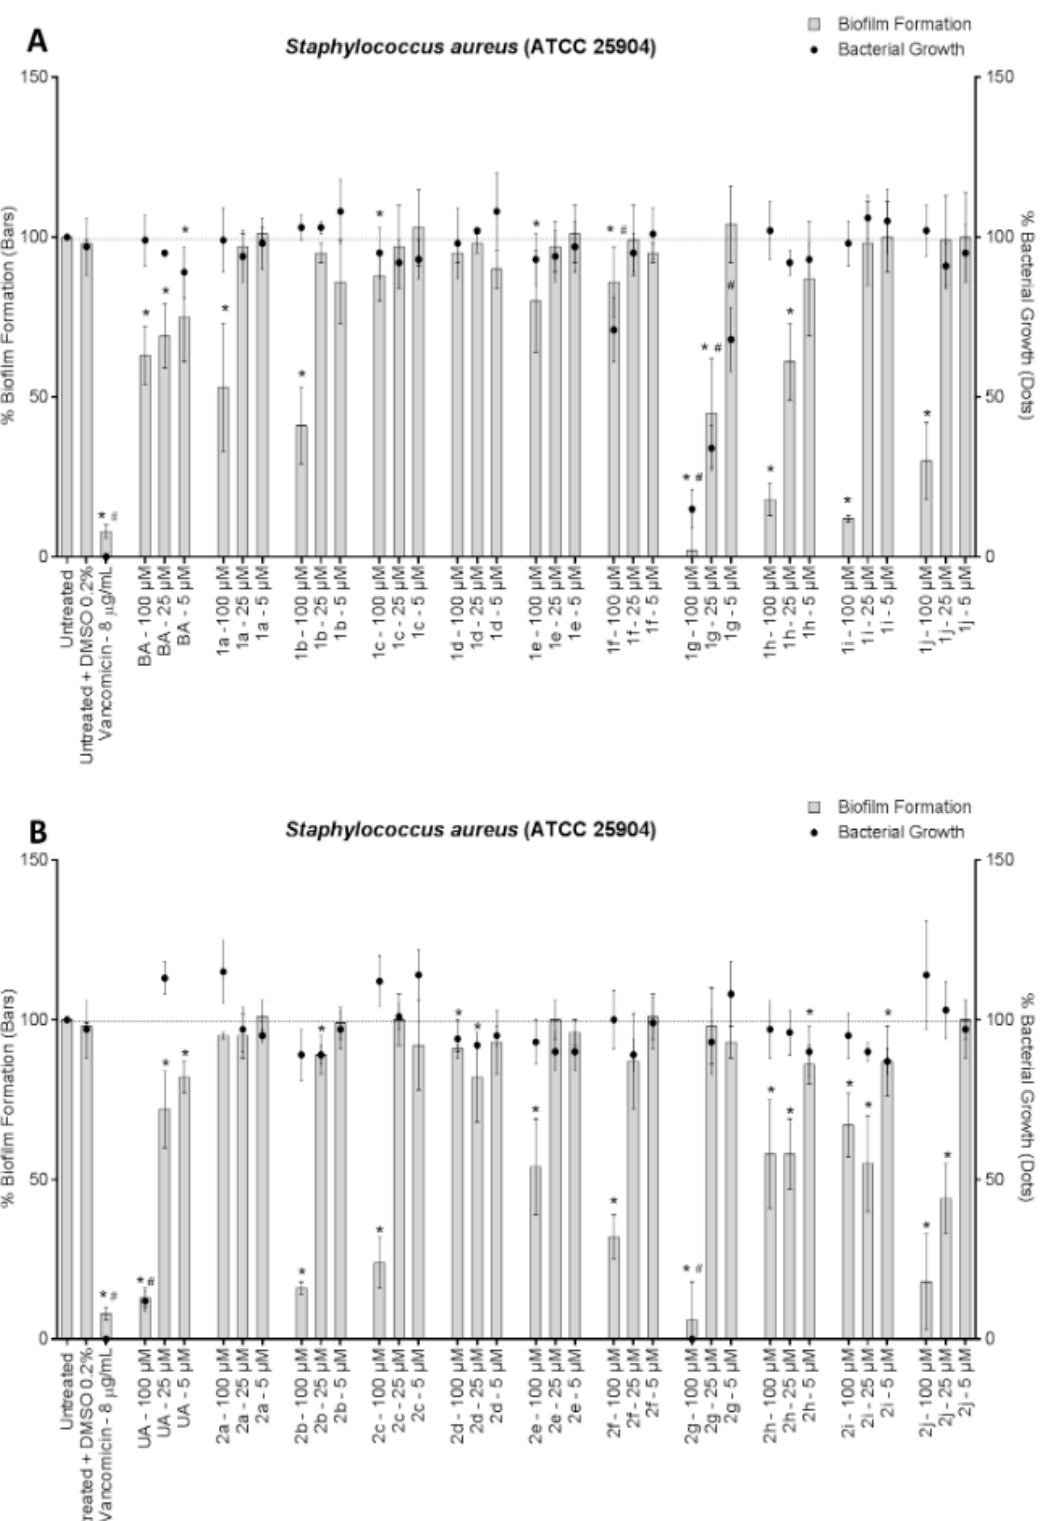
Figure 2. In vitro antibiofilm and antibacterial activity of Staphylococcus aureus : ( A ) BA and derivatives; ( B ) UA and derivatives. Results represent mean ± standard deviation of five experiments. * Represents a significant difference in relation to the biofilm formation control ( p < 0.01). # Represents a significant difference in relation to the planktonic cells’ viability control ( p < 0.01). BA: betulinic acid; UA: ursolic acid.